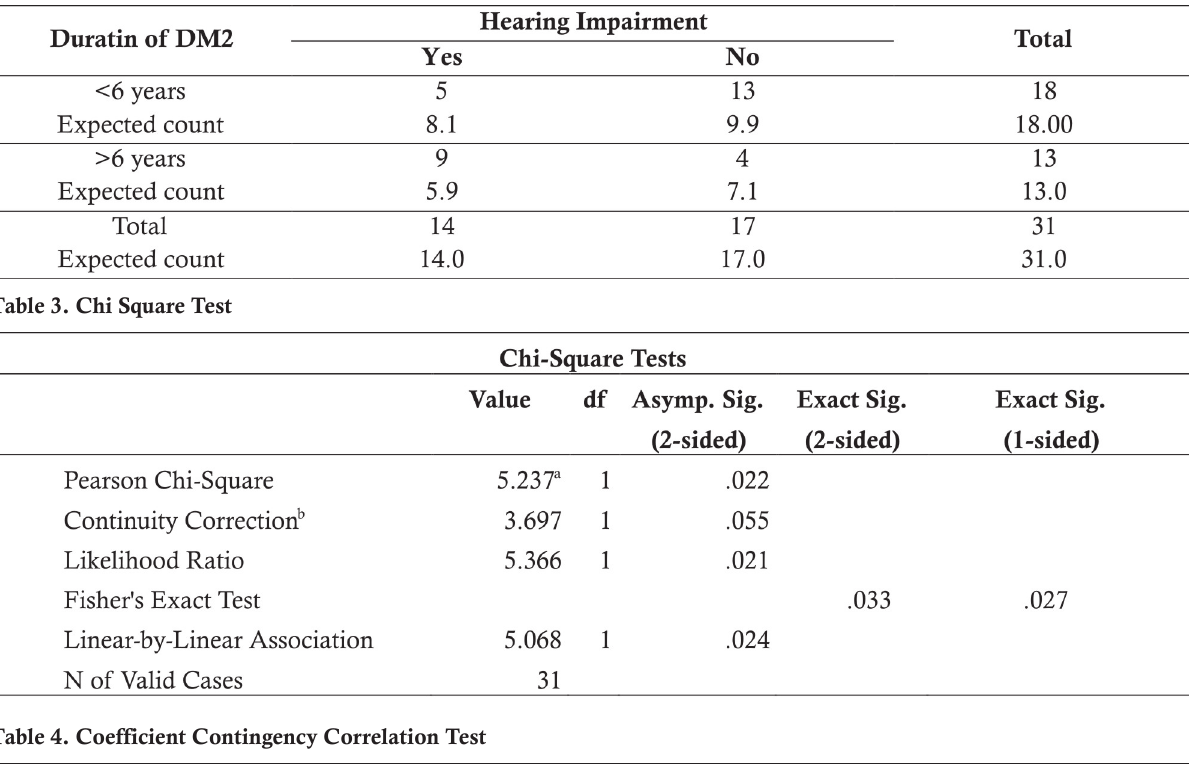
Table . Cross table between duration of DM and hearing impairments